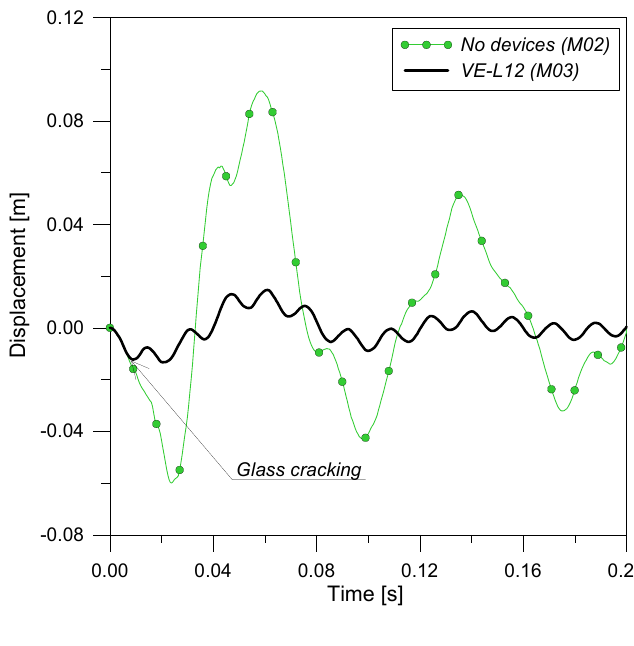
Figure 16. Comparison of deflection at the center of